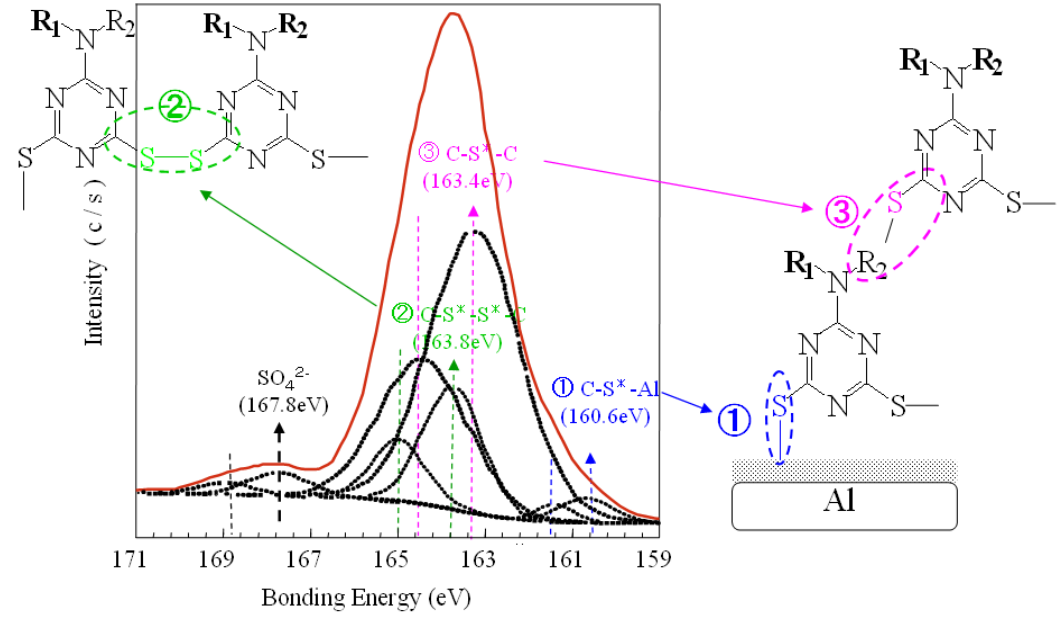
Figure 2. S2p fitted curve of high resolution XPS spectra from polymeric film on aluminum plate in 45 tilt degree (X-ray anode: Al monochromated 2 nm filament; Aperture: 800 × 200 μ